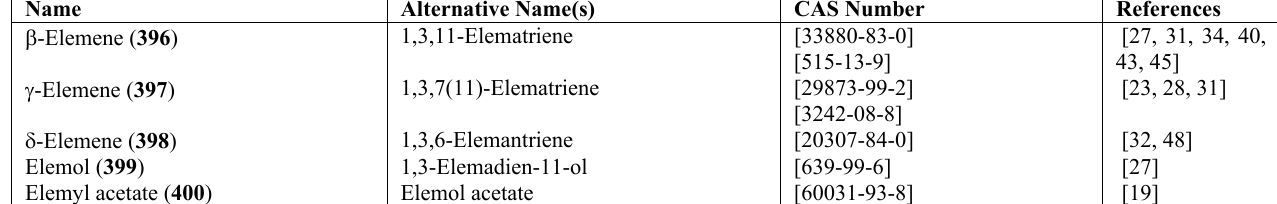
Table 32. Elemane Sesquiterpenoids (1-Ethyl-1-methyl-2,4-bis-(1-methylethyl)cyclohexane,